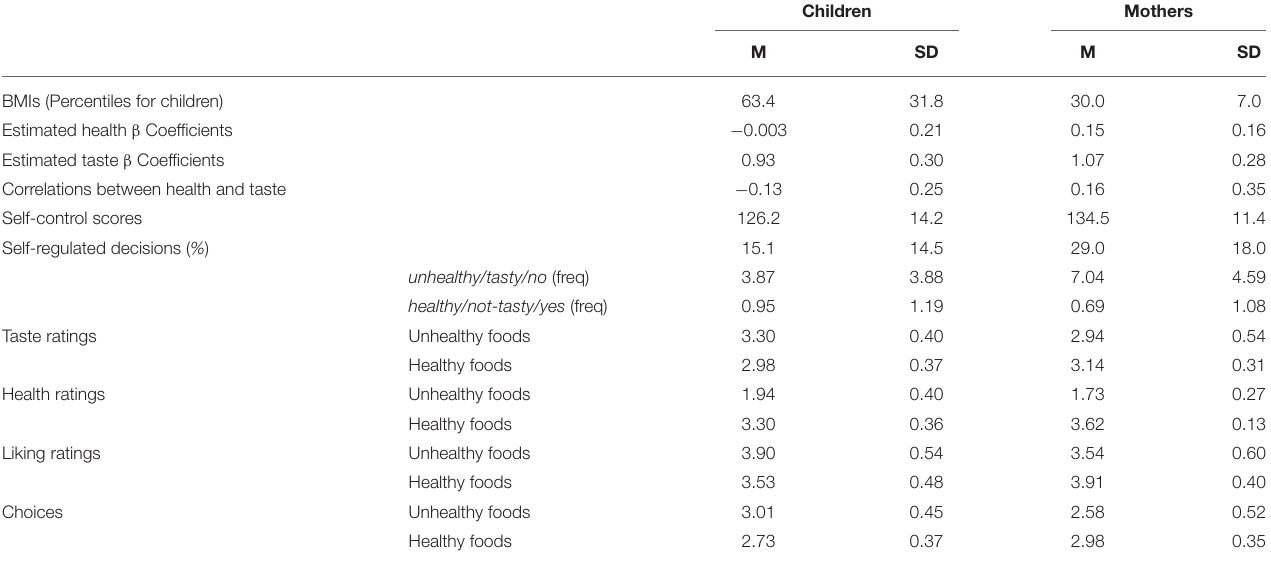
TABLE 1 | Descriptive